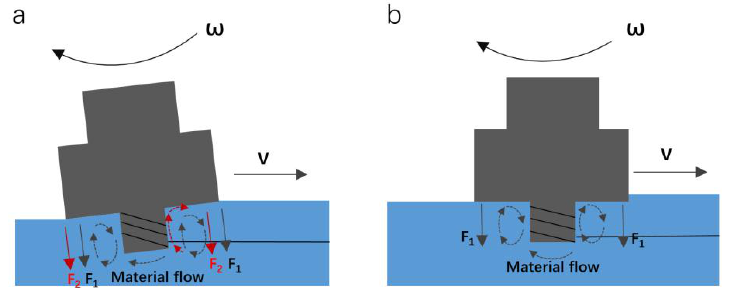
Figure 6. Schematic of metal flow and molding pressure: ( a ) FSLW process with tilt angle and ( b ) FSLW process without tilt angle.